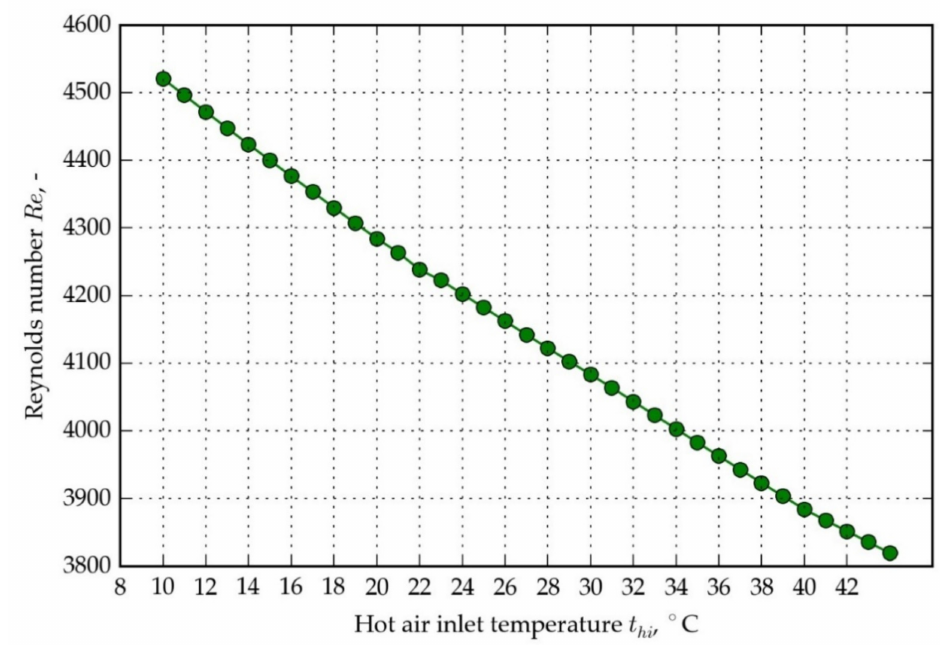
Figure 11. Reynolds number vs. hot air inlet temperature, for cold stream inlet temperature 0 ◦ C and 20 HPs rows.